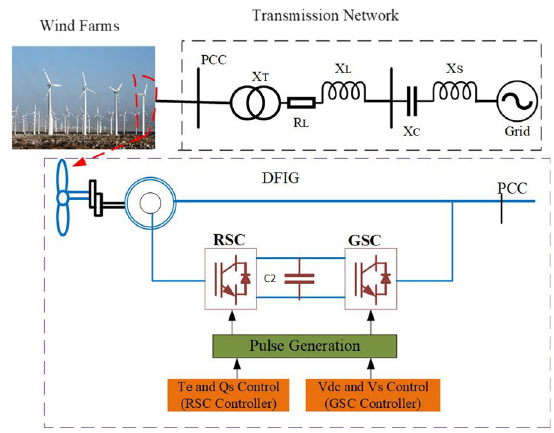
Fig. 5 DFIG-based WTC control